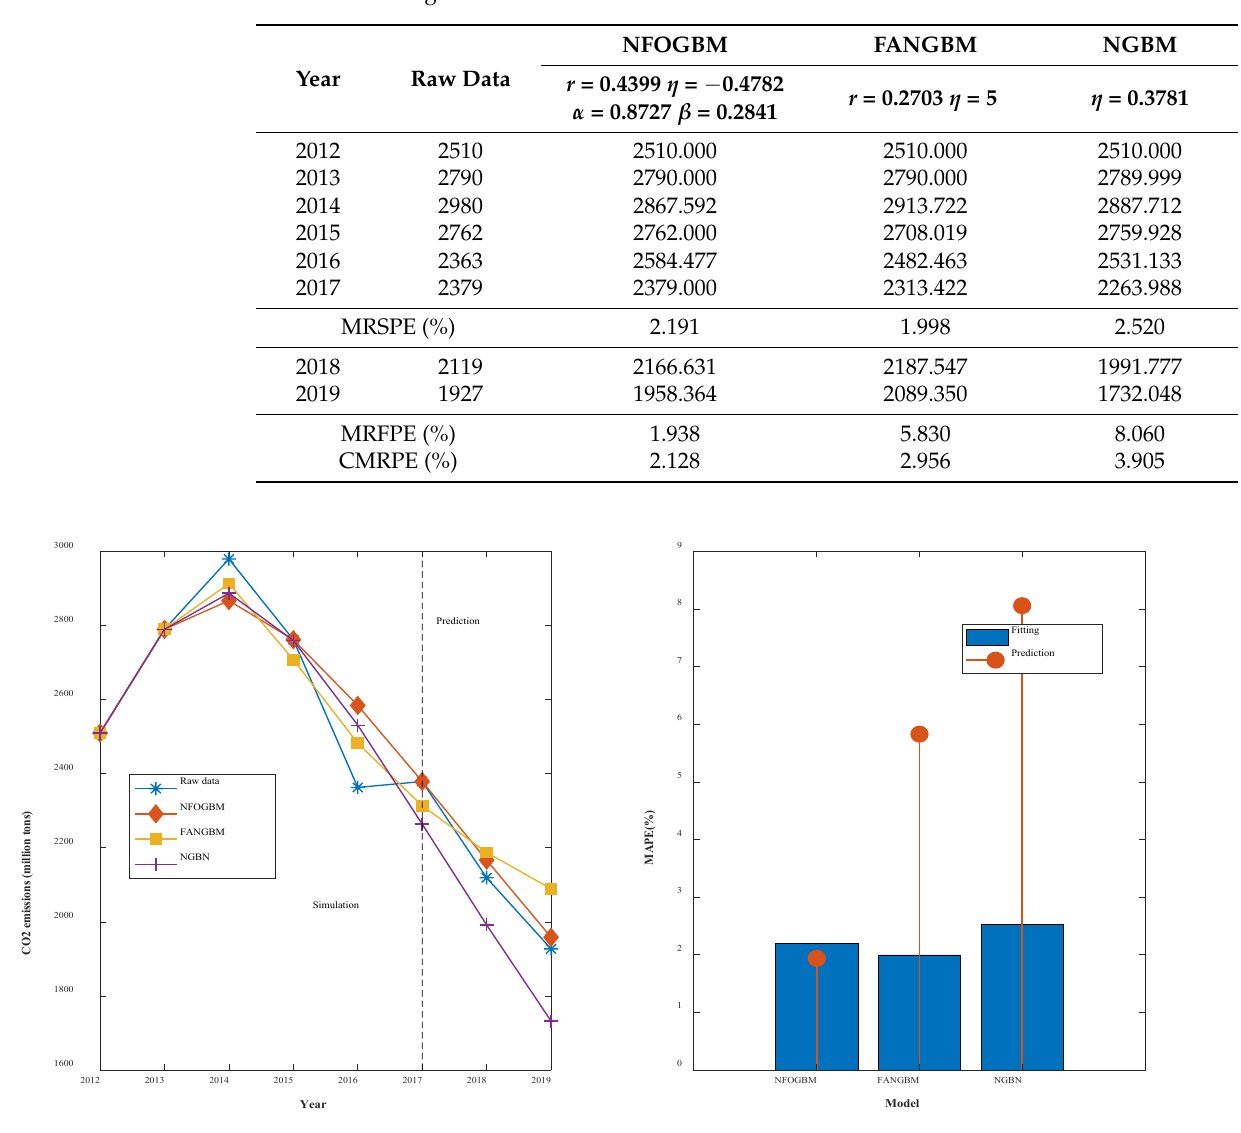
Table 6. Modeling results for NMMD.